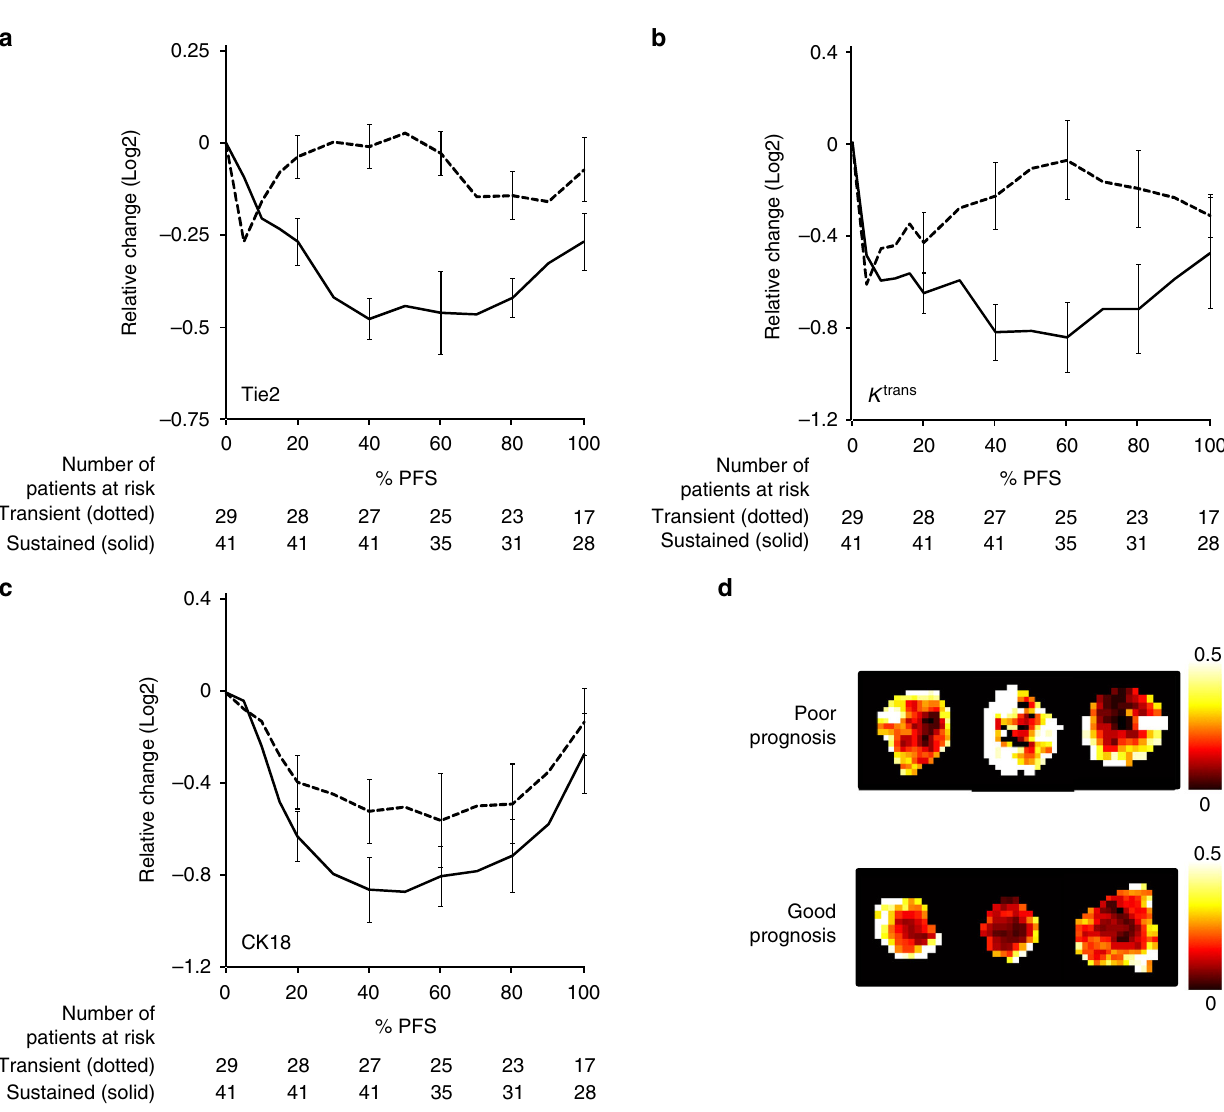
PFS (Fig. 2b: median PFS 248 vs. 348 days, p = 0.0008, Log rank test. HR for progression: 3.01, p = 0.00014, Wald test). As VEGF-